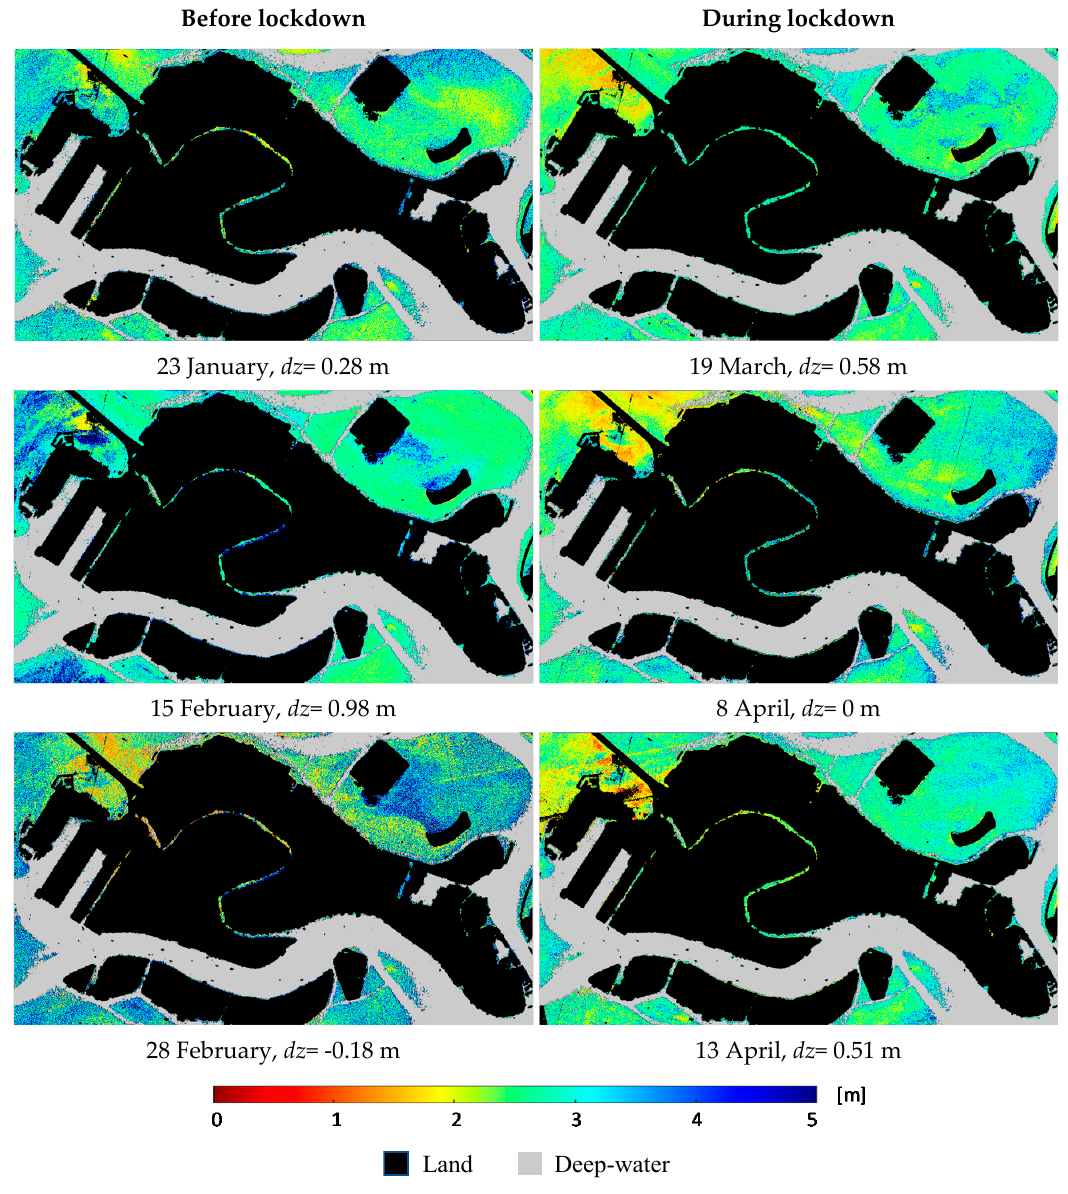
Figure 5. Consistency of bathymetry maps before and during the lockdown for very different TSM concentrations, indicating that the applied method has the potential to derive water depth in shallow areas from PlanetScope data even in relatively turbid waters.